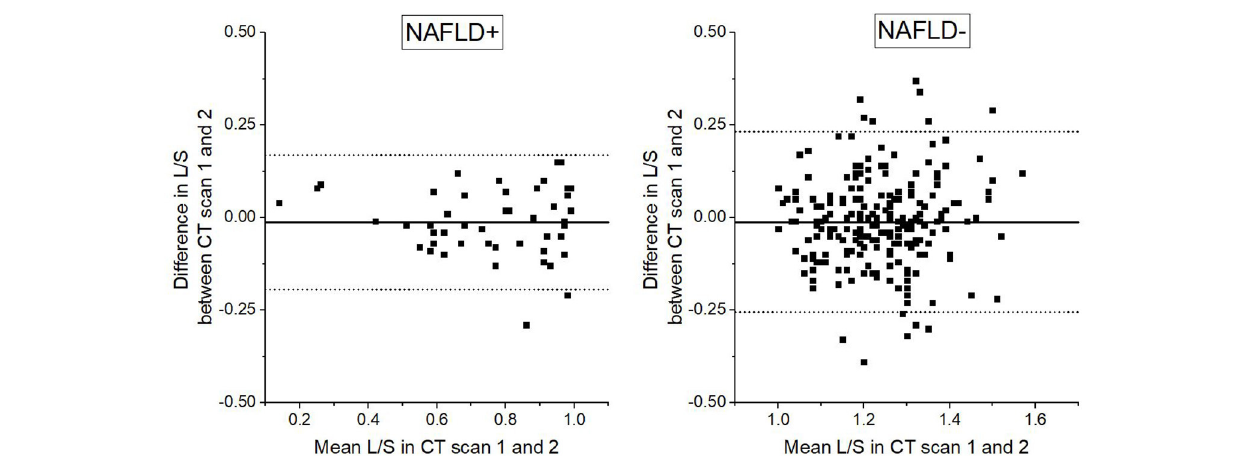
FIGURE 3 | Bland-Altman plot demonstrating differences in liver to spleen ratio (L/S) based on radiodensity values in repeated low dose computed tomography scans in relation to mean of the two L/S assessments. Straight horizontal line represents mean difference, dotted horizontal lines represent upper and lower 95% limits of agreement. L/S cut of value of 1 is used in division of study population to subjects with non-alcoholic fatty liver disease (NAFLD + ) and subjects without non-alcoholic fatty liver disease (NAFLD–).